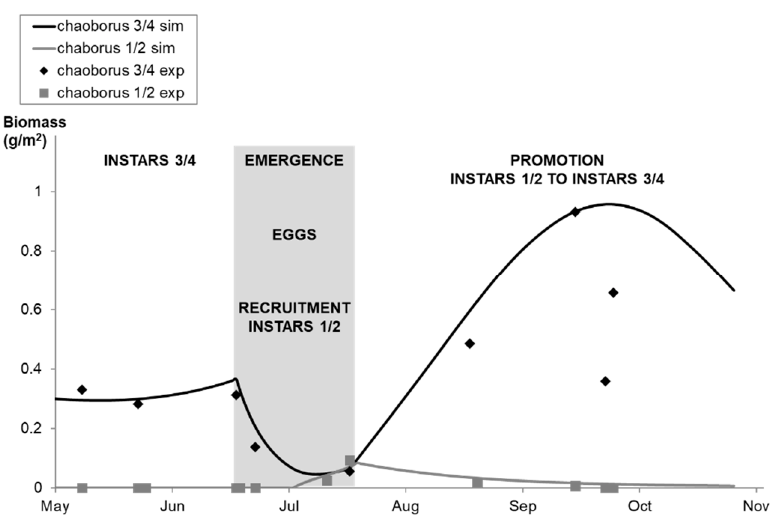
Figure 5. Calibration results for Chaoborus (abbreviations: exp = experimental data; sim = simulation results).